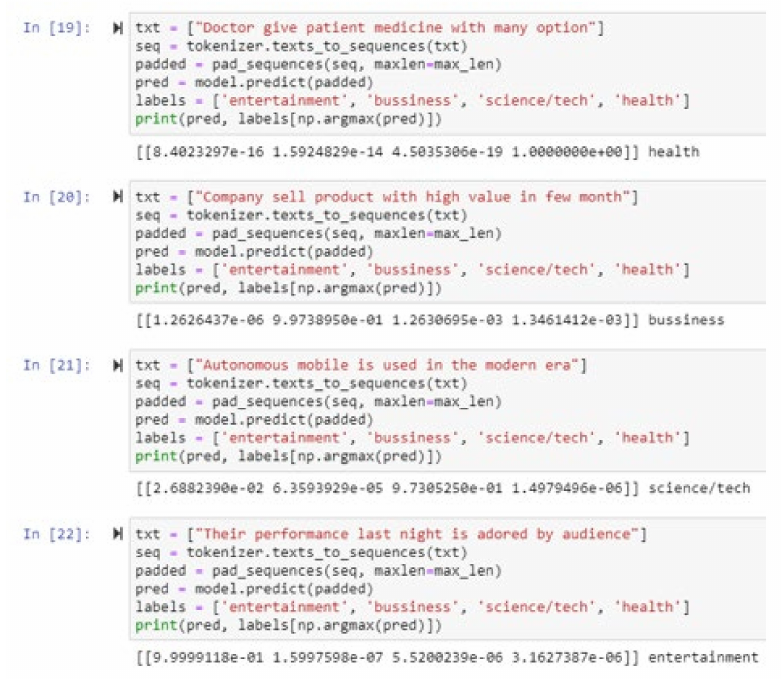
Figure 8. Sentence testing in [" "], the sentence test in [" "], with the next 4 sentences, a sentence test that is made independently is carried out with the aim of whether the test results can be applied to the new sentence (one example of the test results of the File 22 program with program details as shown in Table